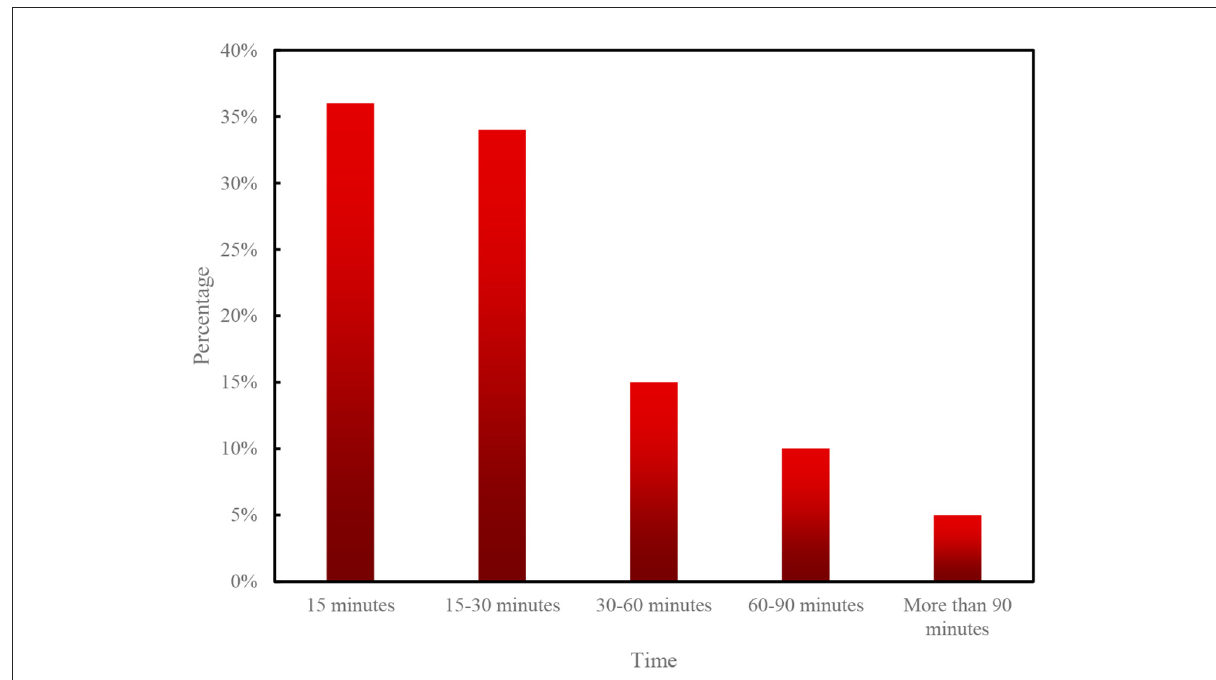
FIGURE9 Legend of the percentage of physical exercise time for the physically handicapped.